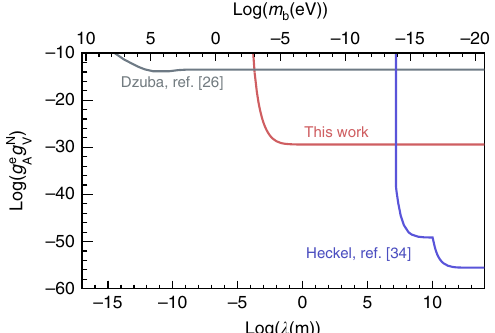
Fig. 5 Experimental constraint on the interaction V. The red curve indicates the experimental limit of our experiment on the electron-nucleon coupling g e g N with 1 σ uncertainty as a function of the interaction range λ in the A V bottom axis and the boson mass m b in the top axis. Our experiment is sensitive for m b < 10 − 3 eV and λ > 10 − 4 m. The gray line indicates the same coupling which can be also derived from atomic parity non-conservation (PNC) experiments 26 . Our experiment signi fi cantly enhances the constraint for g e g N by 17 orders of magnitude beyond the PNC experiments. The blue A V line indicates the constraint from the electron-spin polarized